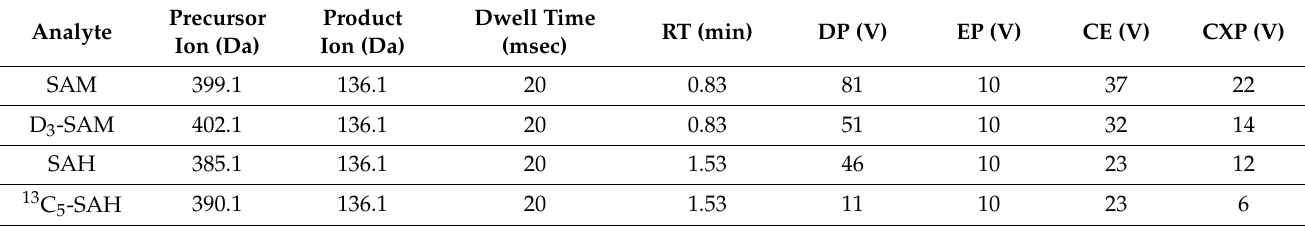
Table 1. Mass transitions and optimised parameters for SAM and